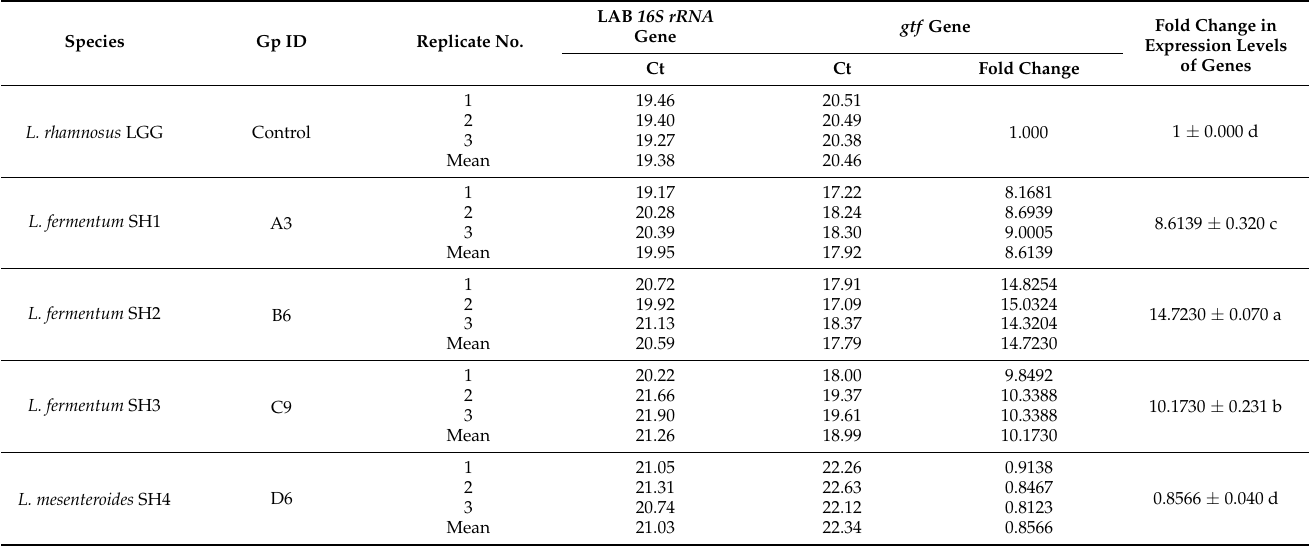
Table 2. The variation of gene expression on the RNA of the different treatments (LGG control, A3, B6, C9, D6), which were expressed as the fold change in expression levels of the target genes. LAB 16S rRNA gtf Gene Fold Change in Gene Species Gp ID Replicate No. Expression Levels of GenesCt Ct Fold